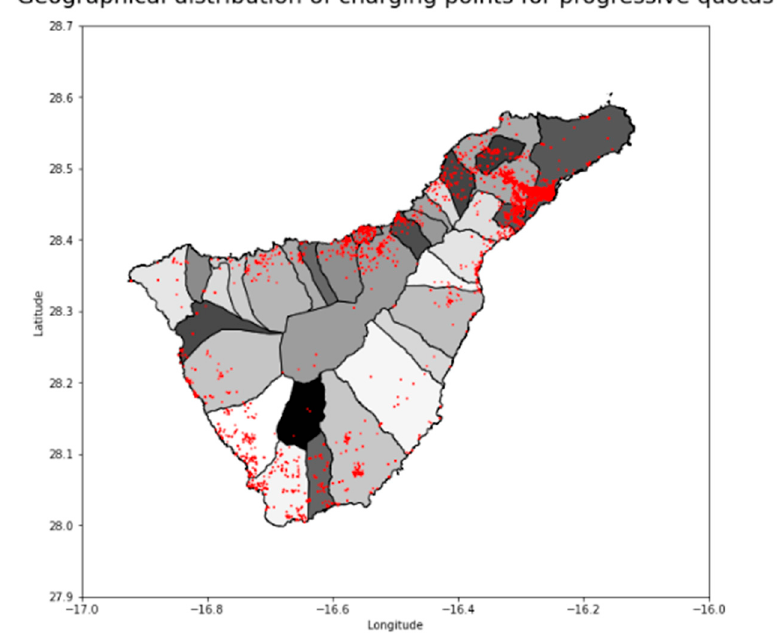
Figure 24. Distribution of charging points in Tenerife in 2028 for the progressive case.